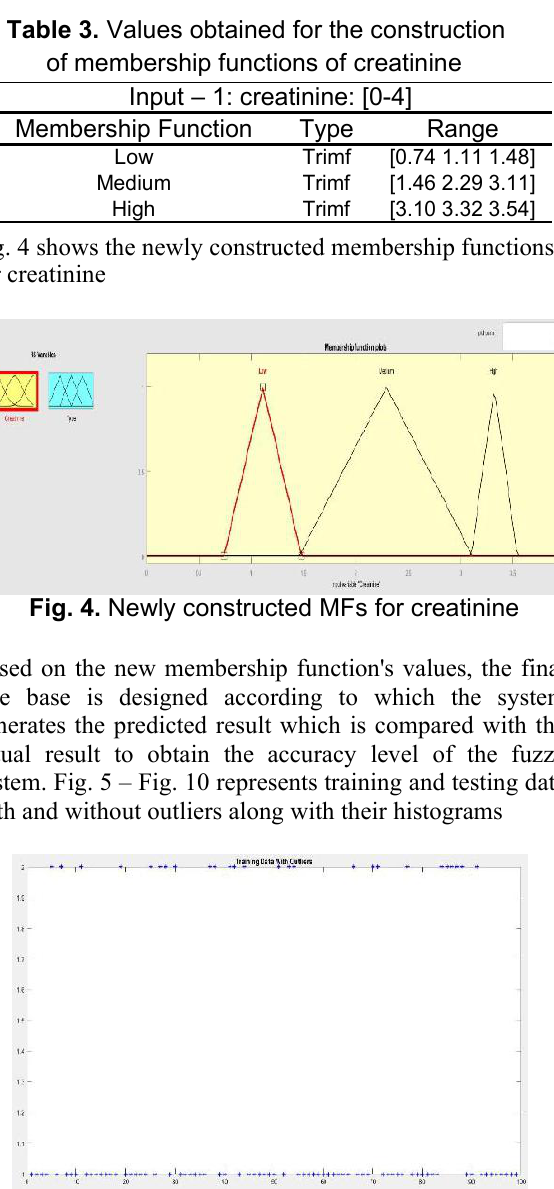
Fig. 5. Training data with outliers Fig. 5 represents training data set before the removal of outliers. Out of 99 patient’s data, the data of 70 patients are used for training the data set.